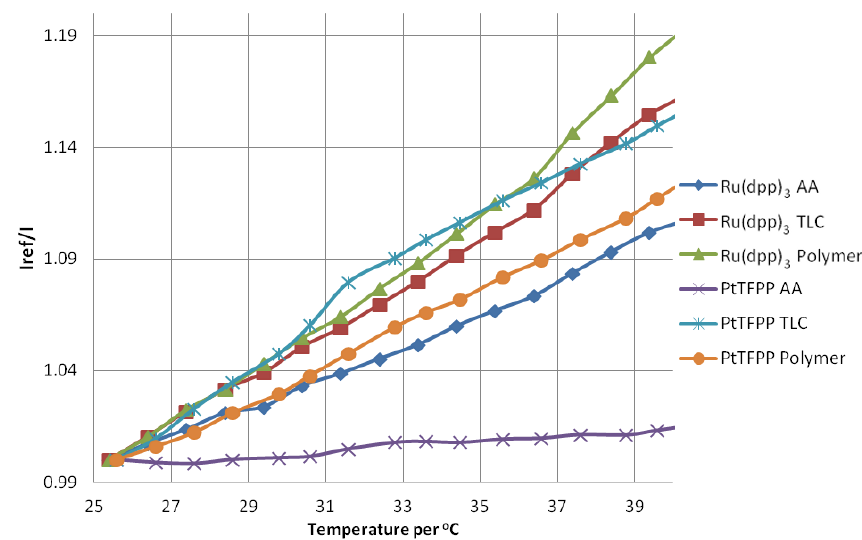
Figure 9. Temperature Sensitivity of PSP Samples.